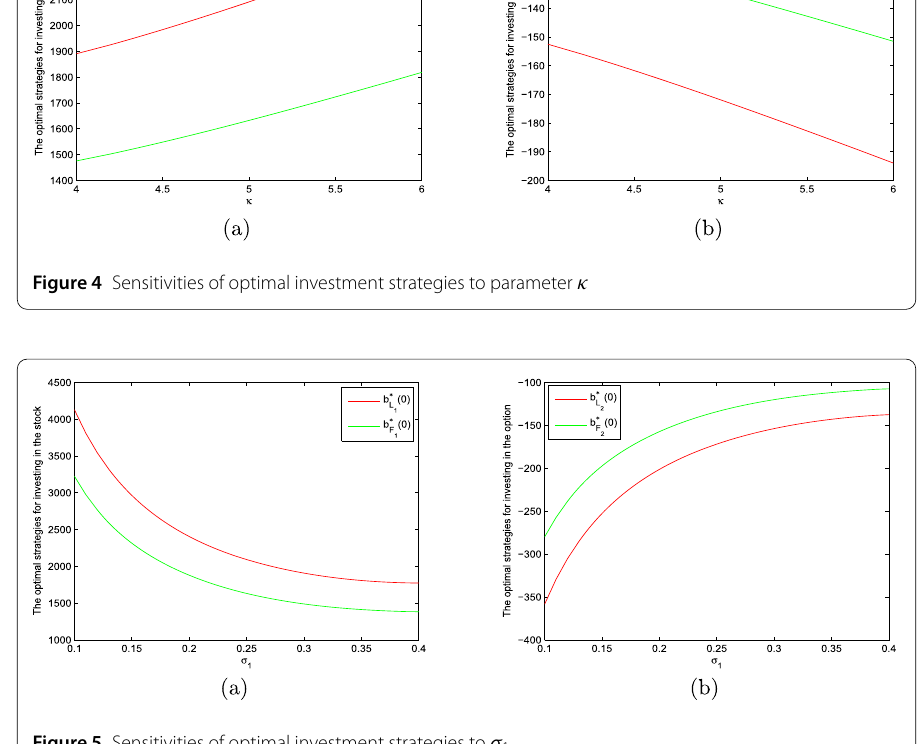
Figure 5 Sensitivities of optimal investment strategies to σ